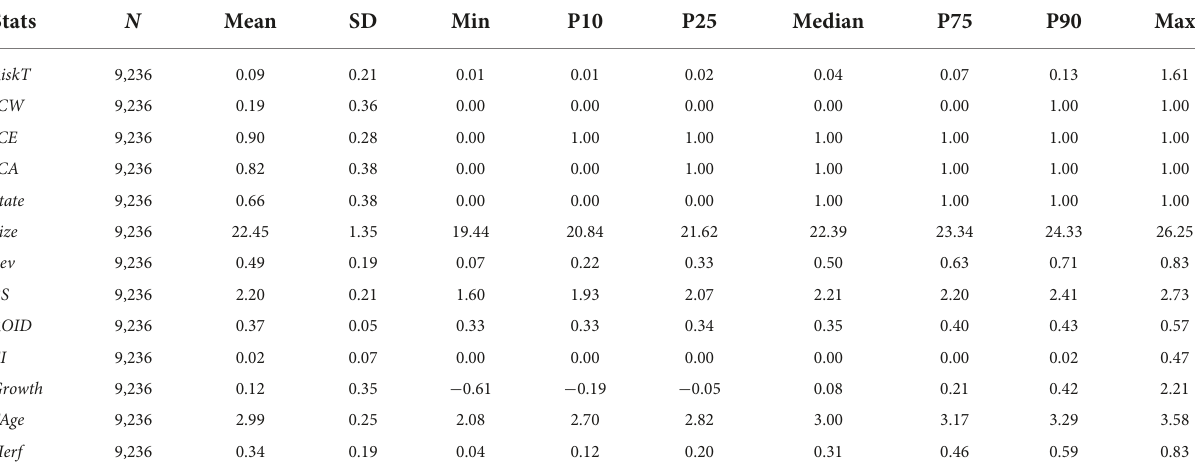
TABLE 2 Descriptive statistical